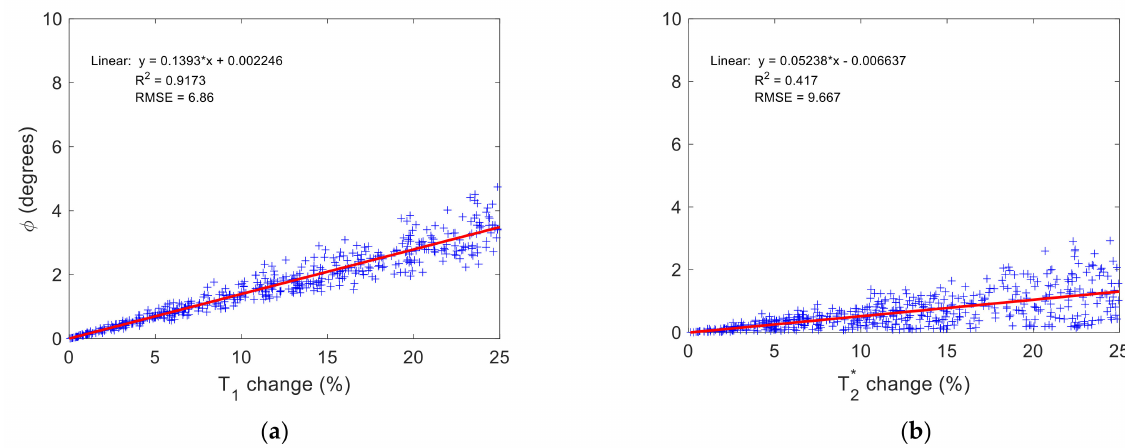
Figure 3. Illustration of the sensitivity of time fractional Bloch model to changes in each of the model parameters. On the x -axis, the change in the parameter is provided, plotted against the actual change in the signal and measured as the angle between the two vectors (i.e., dot product, as used for matching the simulated signal with acquired MRF signal). Each data point on each plot has been generated by randomly choosing parameter values from the appropriate parameter ranges. Each figure contains 500 random instances and percentage error change in the parameter was also chosen random in the range (0, 25%). Displayed are sensitivities to changes in ( a ) T 1 , ( b ) T ∗ , ( c ) α , ( d ) β , ( e ) ∆ f and ( f ) assuming the special case 2 of α = 1 for β sensitivity. For each plot, a linear regression was performed and R 2 and root-mean-squared error (RMSE) are